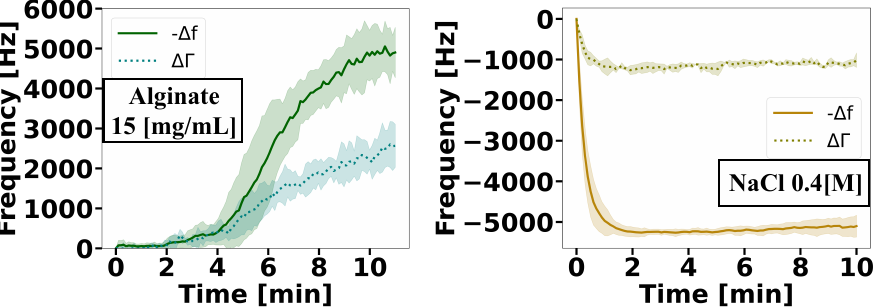
Figure 3. ( left ) ∆ f and ∆Γ changes after placing an alginate solution (15 mg/mL) on the sensor. Gelation was performed once the signal had stabilised. ( right ) ∆ f and ∆Γ change likely caused by a dilution effect following the exposure of the alginate to a solution of NaCl (0.4 M). The shaded area denotes the standard deviation as obtained from measurements of n = 3 independent